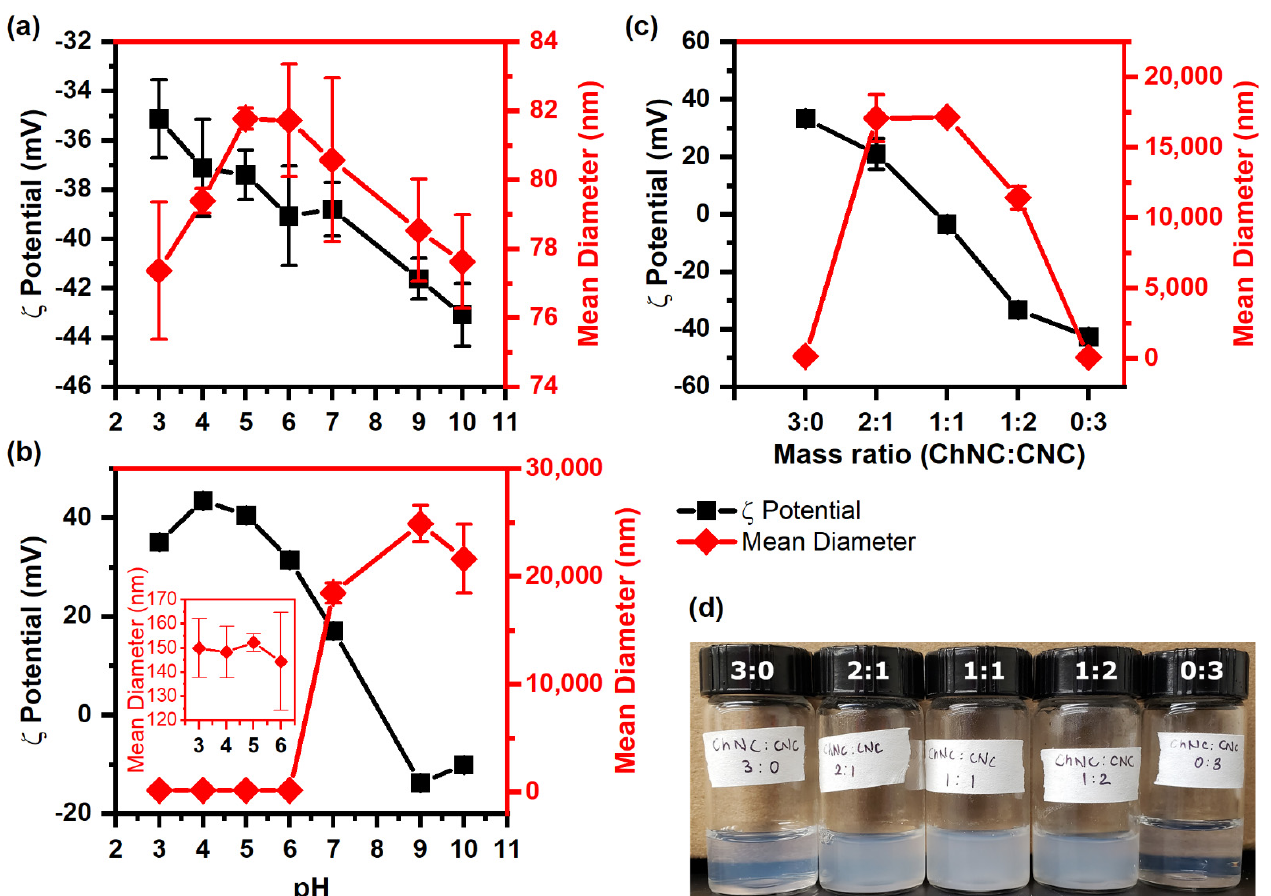
Figure 1. ζ -potential and mean aggregate size of ( a ) CNC, ( b ) ChNC, and ( c ) ChNC-CNC nanoconju- gates at pH 6. ( d ) Picture of ChNC-CNC complexes in aqueous dispersion. In ( a ), the CNCs show a negative charge over the entire pH range with stable hydrodynamic diameters between 76 and 82 nm, indicating no aggregation. In ( b ), the ChNCs are positively charged below the isoelectric point at pH 8 and negatively charged above it, while their hydrodynamic diameter indicates no aggregation at pH 6 and below, but significant aggregation at pH 7 and above. In ( c ), the combination of ChNCs and CNCs neutralize the charges, leading to significant flocculation in the mixed samples.